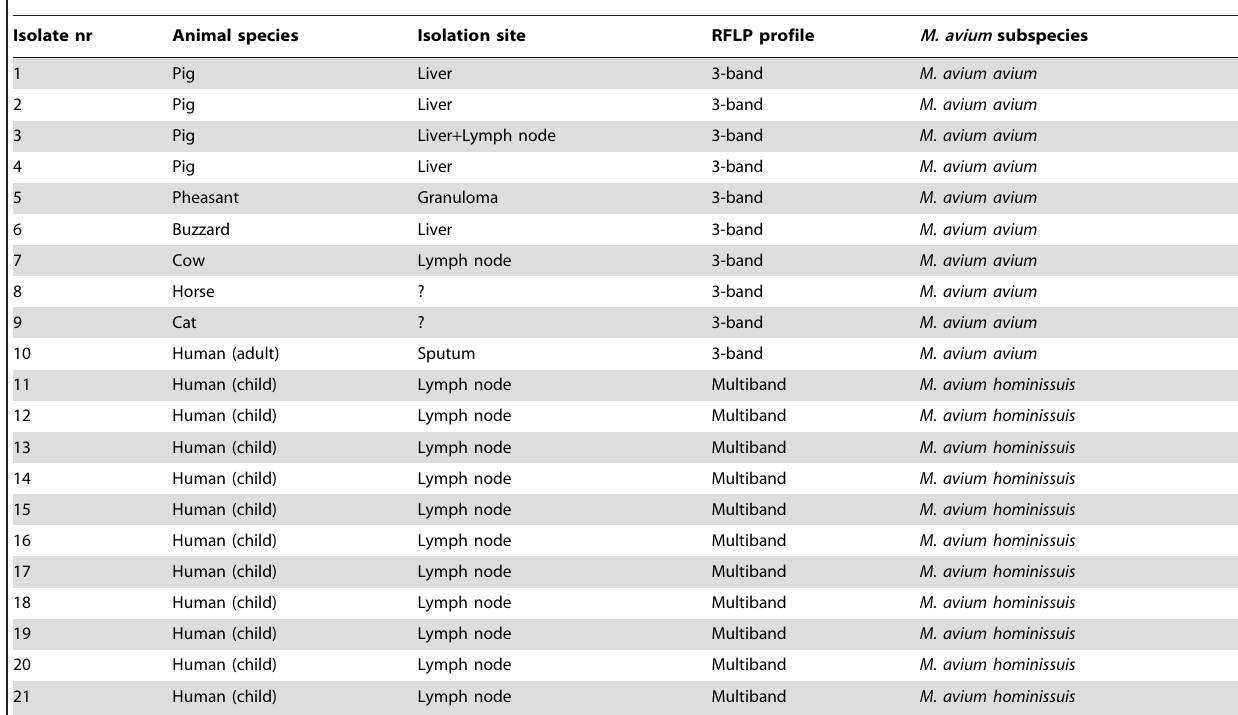
Table 1. Mycobacterium avium strains included in this study.